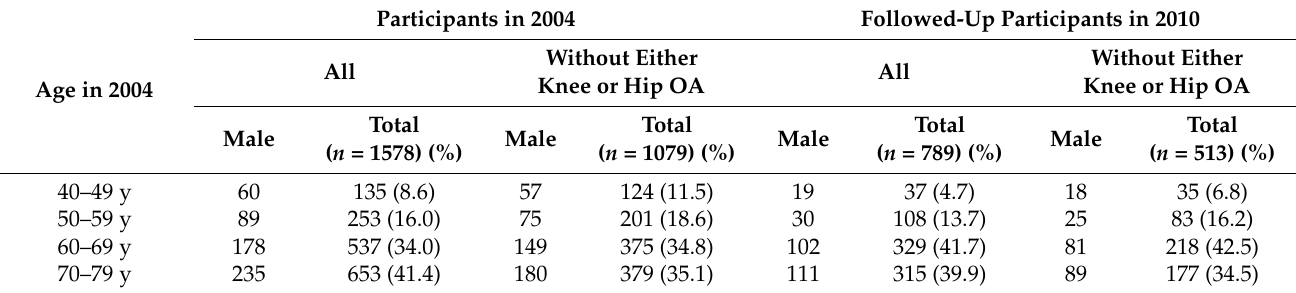
Table 1. Proportion of participants in 2004 (initial assessment) and 2010 (six-year follow-up) by age group.